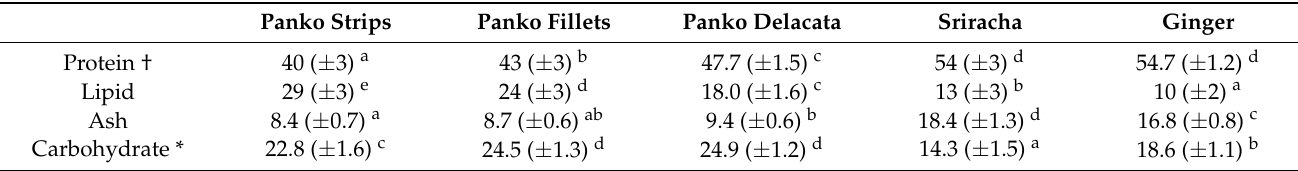
Table 2. Proximate compositions (dry weight